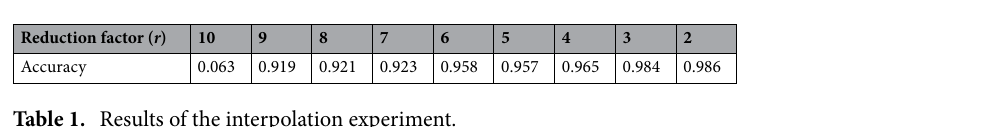
Table 1. Results of the interpolation